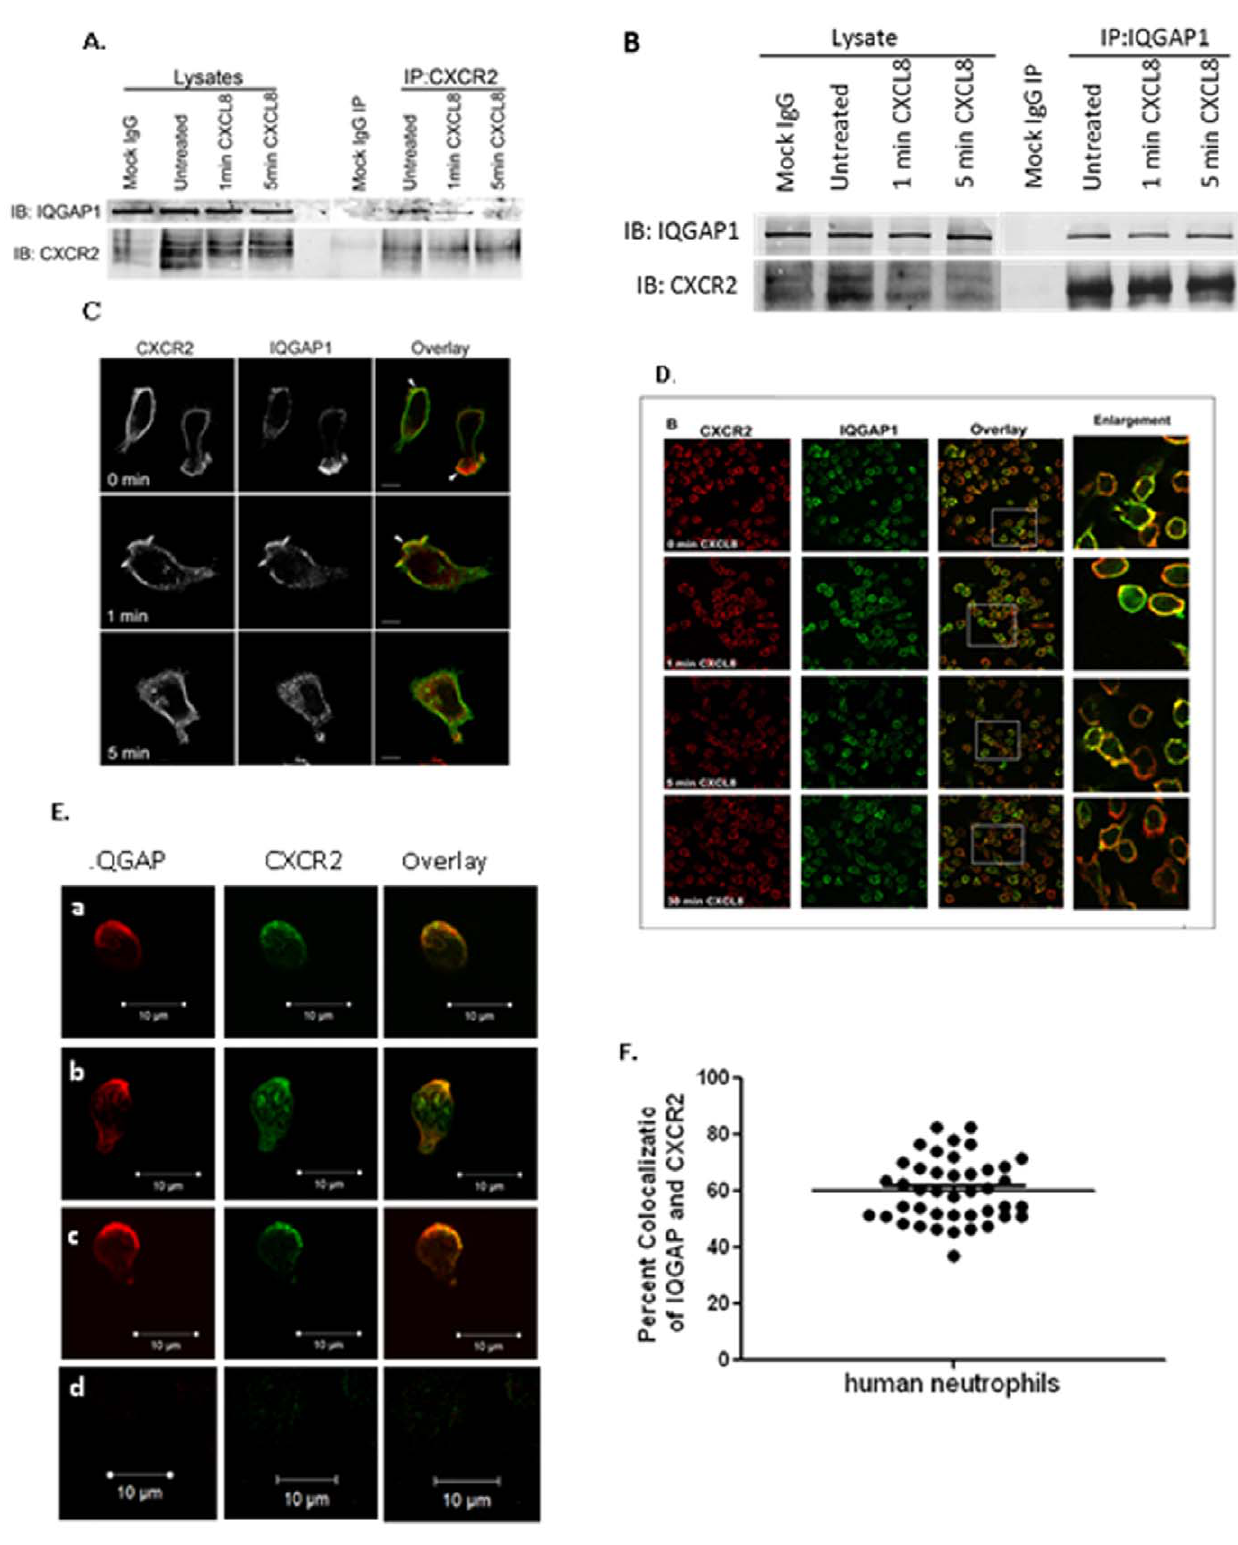
Figure 2. IQGAP1 is a novel CXCR2 interacting protein. (A) IQGAP1 co-immunoprecipitates with CXCR2. Lysates from differentiated HL-60 cells expressing CXCR2 stimulated with vehicle (Mock, Untreated) or cells stimulated with 100 ng/ml CXCL8 for 1 min or 5 min were incubated with either normal rabbit IgG- (Mock IgG) or rabbit anti-CXCR2 antibody-coupled sepharose. Beads were washed and immunoprecipitated proteins were eluted with Laemmli sample buffer. Samples were analyzed by SDS-PAGE and western blot (IB) for CXCR2 and IQGAP1. (B) CXCR2 co-immunoprecipitates with IQGAP1-reverse co-immunoprecipitation. Cell lysates were prepared as described above and incubated with either normal rabbit IgG (Mock IgG) or polyclonal rabbit anti-IQGAP1 antibody. Immunoprecipitated proteins were analyzed by SDS-PAGE and western blot for IQGAP1 and CXCR2. (C &